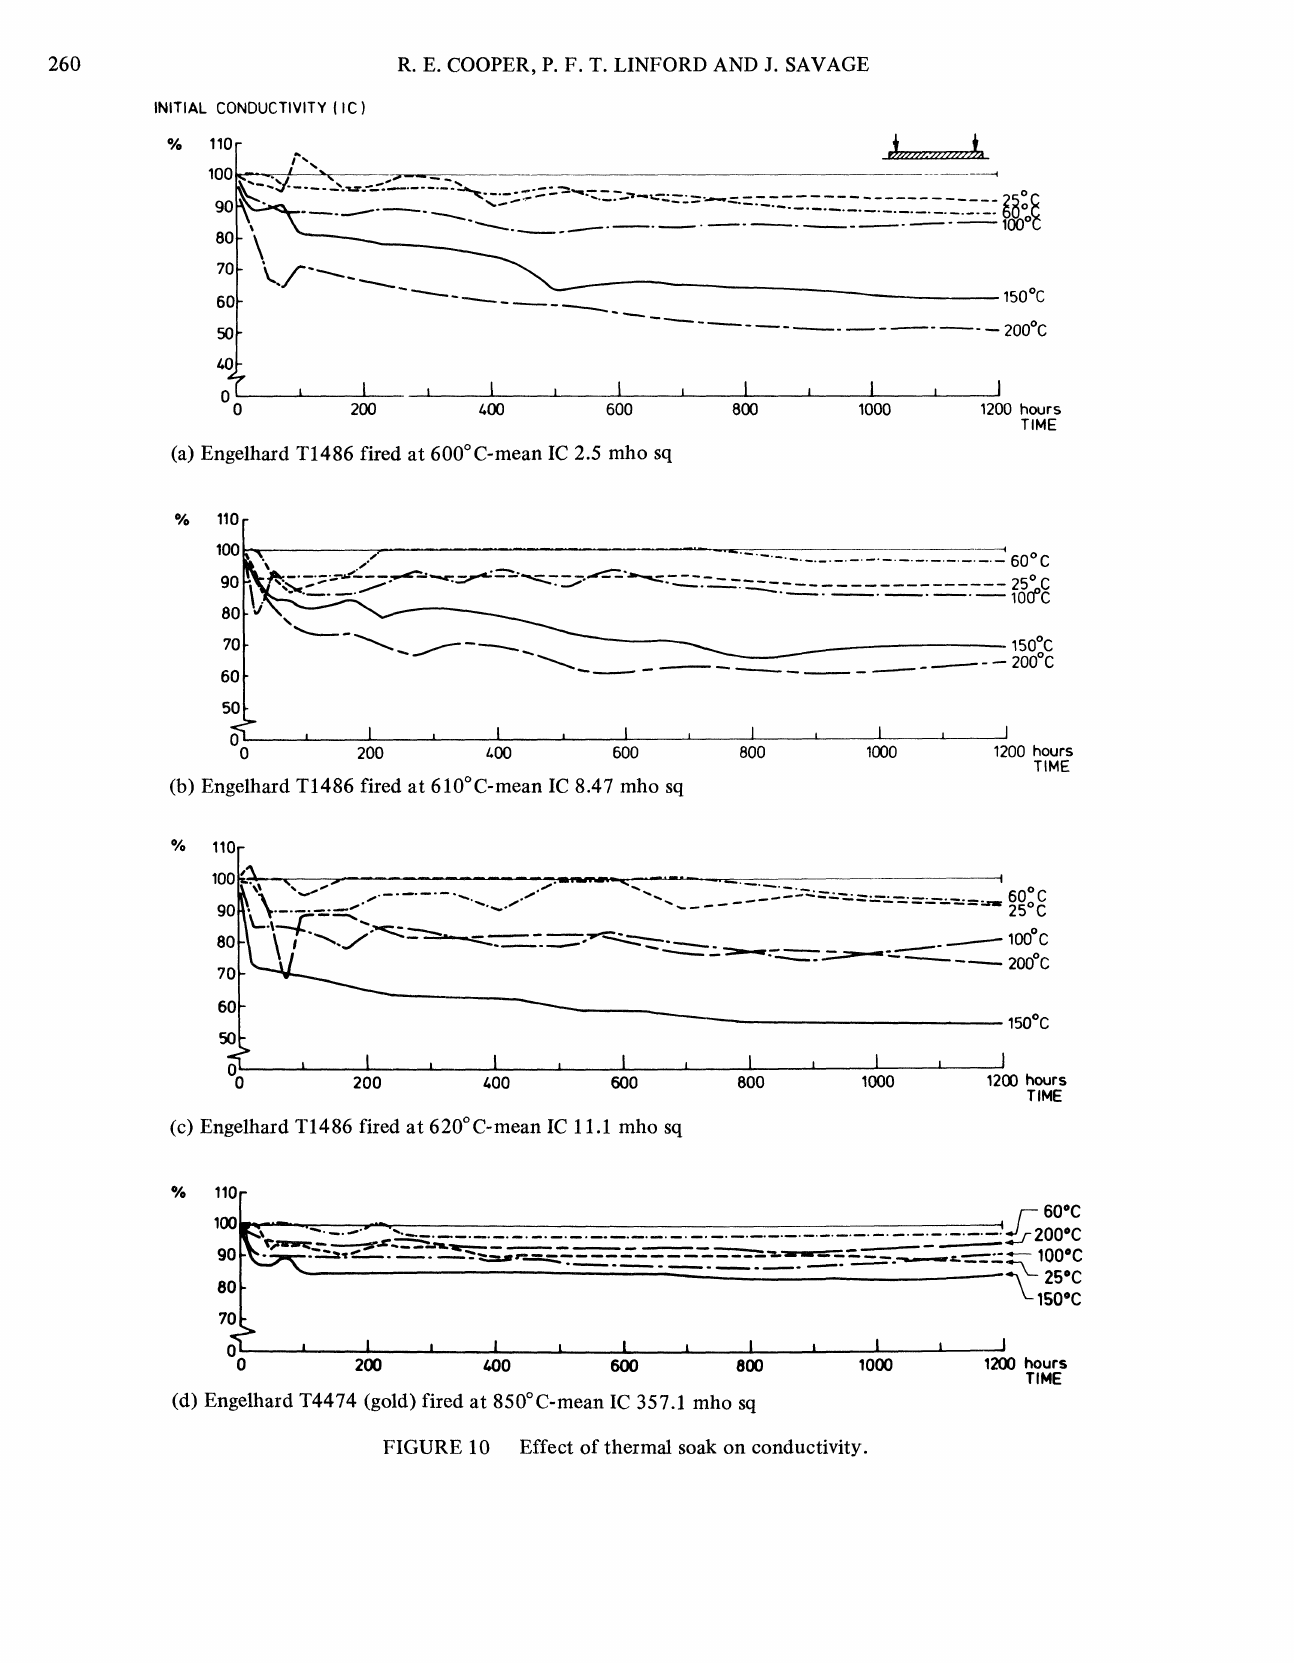
FIGURE 10 Effect of thermal soak on